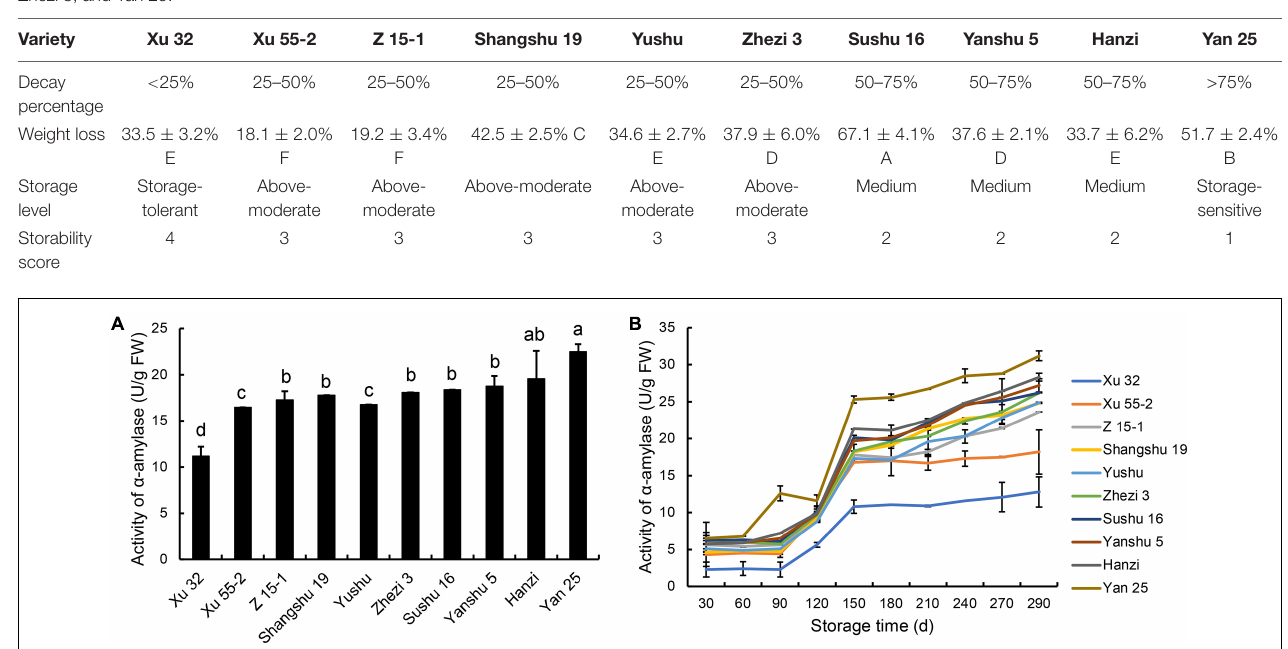
FIGURE 1 | α -amylase activity in the tuberous roots of 10 sweet potato cultivars (i.e., Xu 32, Xu 55-2, Z 15-1, Shangshu 19, Sushu 16, Yanshu 5, Hanzi, Yushu, Zhezi 3, and Yan 25). (A) α -amylase activity in the tuberous roots of 10 sweet potato cultivars before storage and (B) at 30-day intervals during 290 days of postharvest storage. FW, fresh weight; d, days. Different letters above the columns in this figure and following figures stand for significant difference between two values ( p < 0.05).